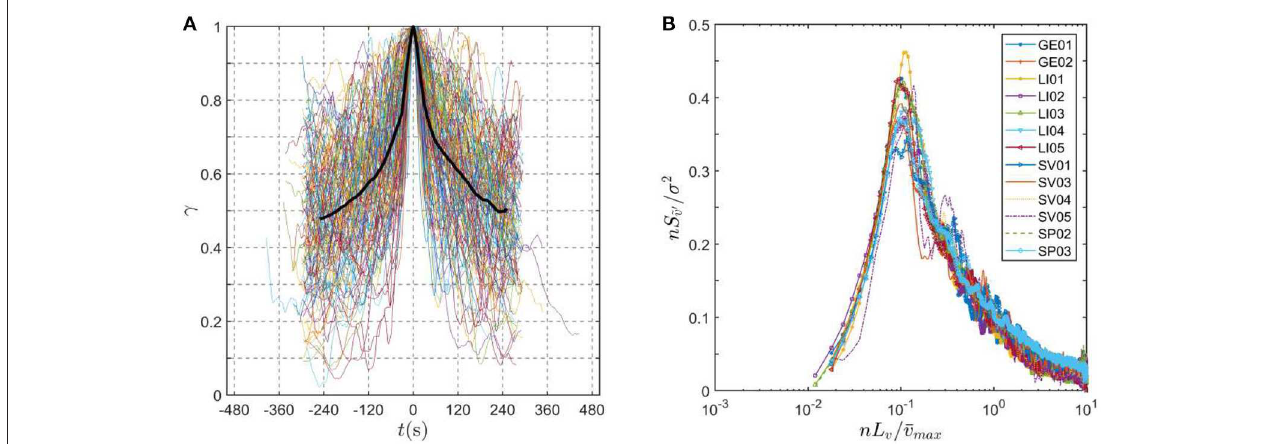
FIGURE 9 | Thunderstorm outflows detected by the WP and WPS monitoring network: (A) slowly-varying mean wind speeds normalised to their maximum and mean value (thick line). (B) mean power spectral density of the reduced turbulence for each anemometer. Reproduced from Zhang et al. (2018a) with permission from